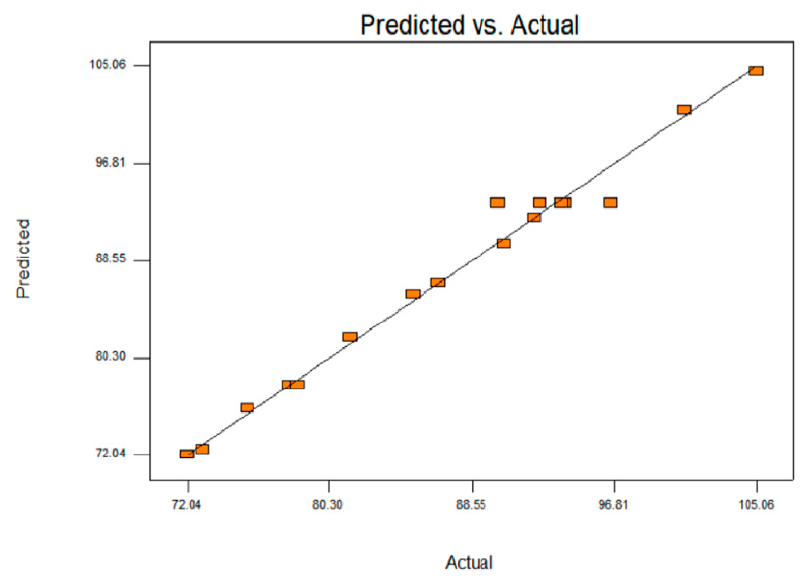
Figure 1. Predicted vs. actual amount of TRS from PALF hydrolysis process.